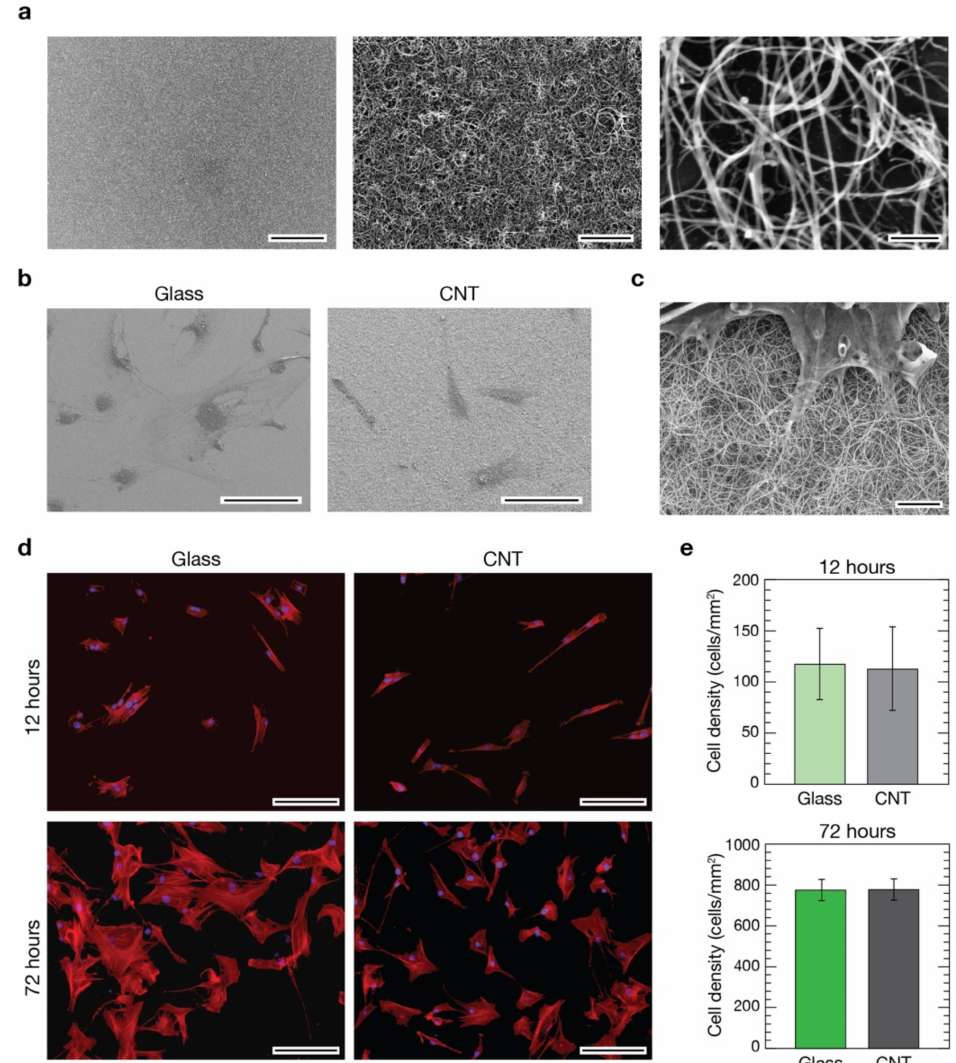
Figure 1. Evaluation of pVICs when developed on glass control and CNT substrates. ( a ) Scanning electron micrographs of CNT substrates at different magnifications pointing out carpet uniformity (left image) and CNT morphology (middle and right images). Scale bars: 50 µ m, 2 µ m, and 200 nm, respectively. ( b ) Low magnification electron micrographs of pVICs grown on a glass control coverslip (left) and a CNT substrate (right). Scale bars: 100 µ m. ( c ) High magnification electron micrograph of a valve interstitial cell growth interfaced with a CNT-decorated substrate revealing the intimate contact between the cell and the filamentous nanotubes. Scale bar: 2 µ m. ( d ) Immunofluorescence images of cells grown on glass (left column) and CNTs (right column) after 12 h (top row) and 72 h (bottom row) from seeding. Cell nuclei were stained in blue using DAPI, while cytoskeletal actin was pointed out in red using phalloidin. Scale bars: 100 µ m. In ( e ), histograms comparing the cell densities calculated from the two different substrates at 12 (top) and 72 h (bottom) time points are shown. No differences were visible in terms of cell densities between controls and CNTs after 12 h (light green and light grey bars, respectively), nor after 72 h (dark green and dark grey bars, respectively, t -test, p > 0.05 at both time